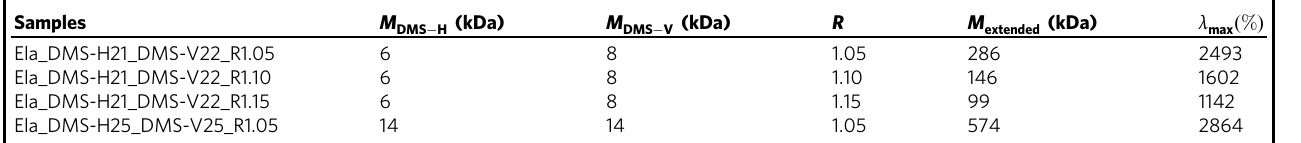
Table 2 Speci fi cations for studied highly stretchable silicone elastomers.